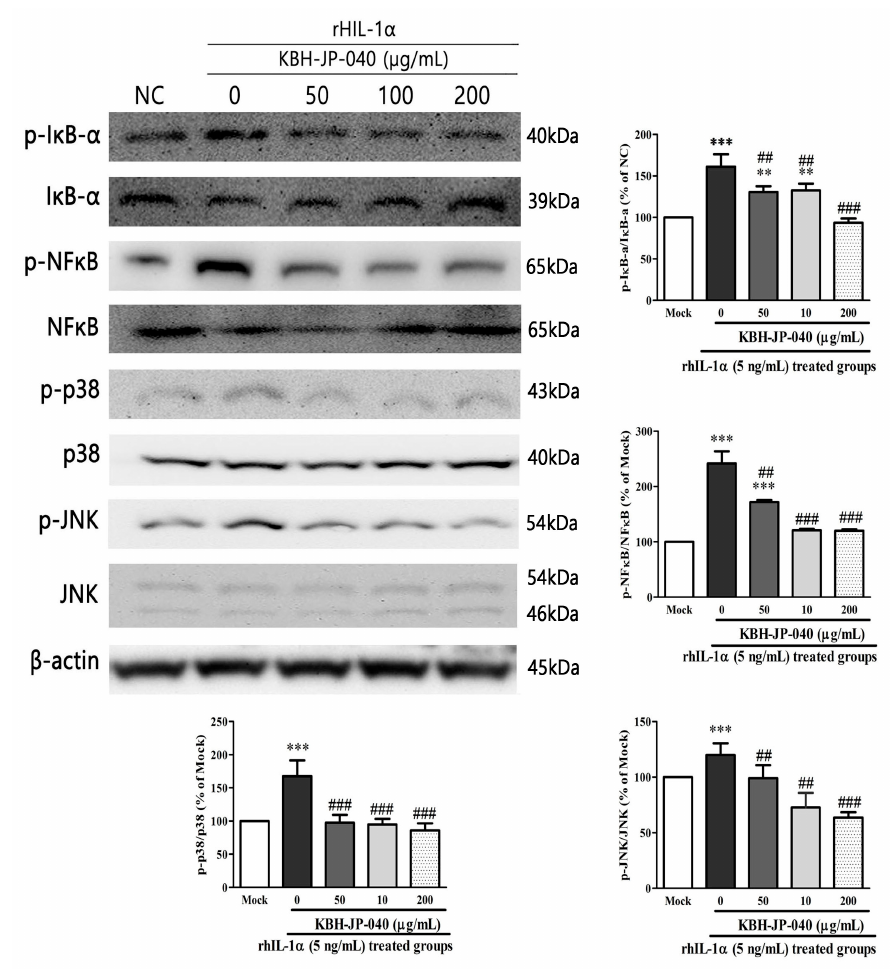
Figure 3. Effect of KBH-JP-040 on pJNK and pp38 MAPK proteins, pIkB α , pNFkB in rhIL-1 α -stimulated chondrocytes. The protein expression of pJNK and pp38MAP kinase IkB α , NFkB was analyzed by Western blot analysis. β -Actin was used as an internal control. Mock, normal chondrocytes;